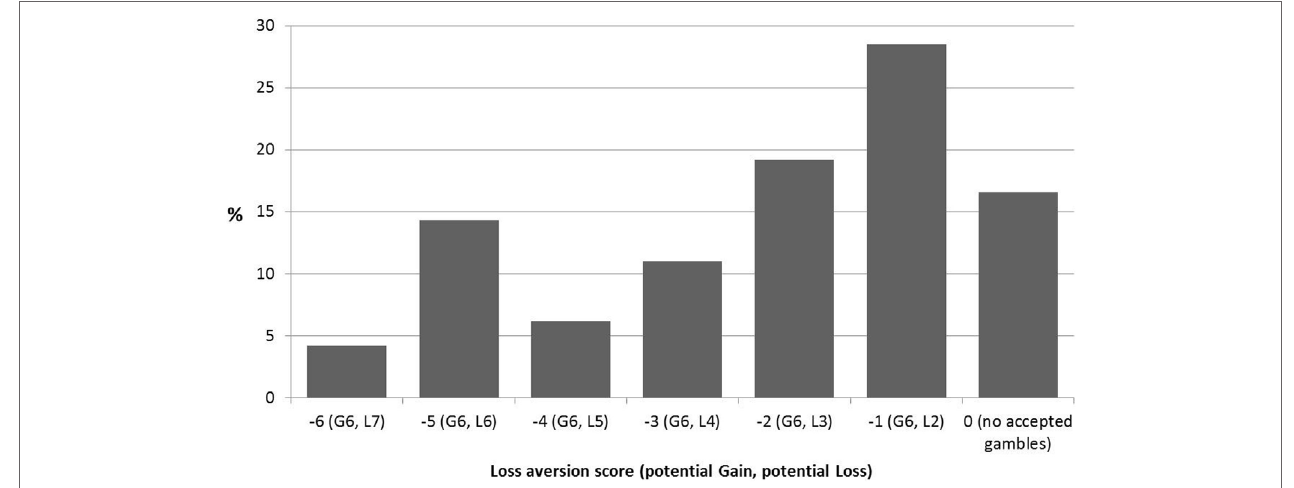
FigUre 2 | Distribution of loss aversion scores in the baseline sample ( N = 2,203). A participant’s score is calculated as: 0 minus the highest (least profitable) accepted gamble. Thus, a score of − 6 indicates very low loss aversion and a score of 0 indicates very high loss aversion. In parentheses, the potential gains (G) and losses (L) for the accepted gambles are shown. The probability of winning or losing the gamble is always 50%. Thus “G6, L7” means a 50–50% gamble with the possibility of a €6 gain and €7